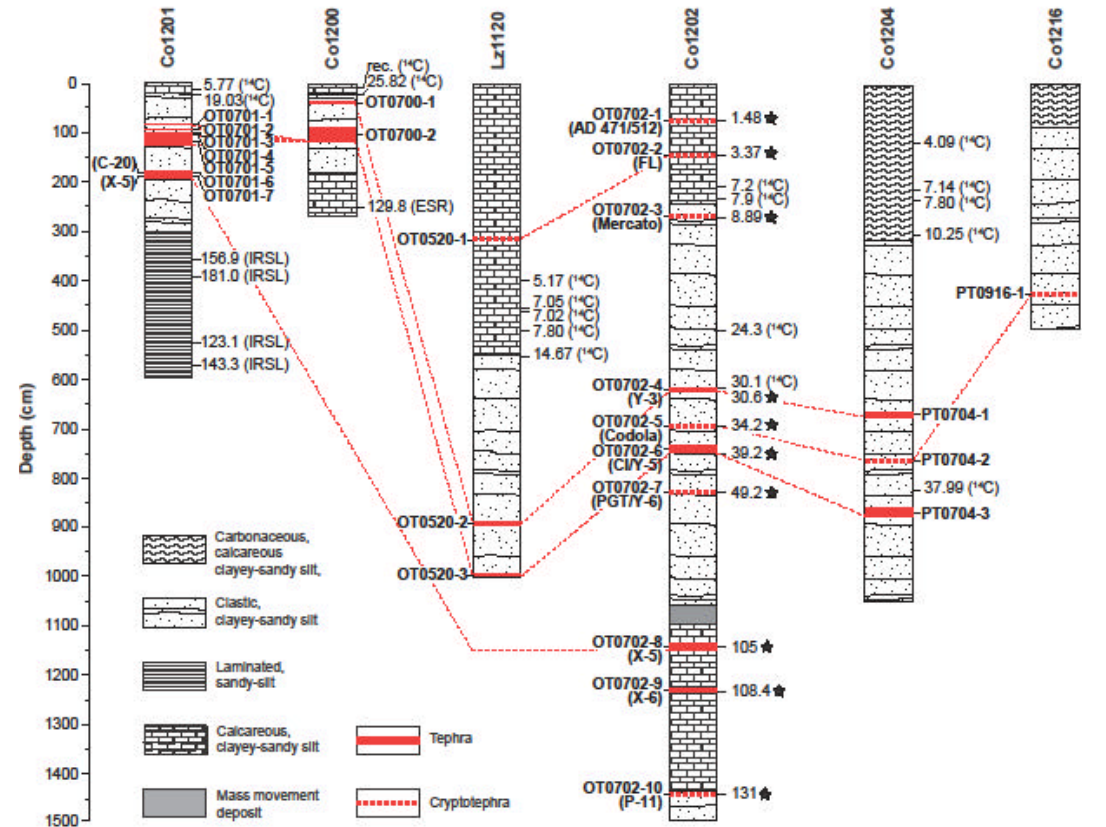
Fig. 2. Summary of stratigraphy and lithology of the studied cores. The thicknesses and sediment depths of tephras and cryptotephras are indicated by red horizons. Nomenclature of tephra layers for cores Co1200 (OT0700-x), Co1201 (OT0701-x), Co1202 (OT0702-x), Lz1120 (OT0520-x), Co1204 (PT0704-x), and Co1216 (PT0916-x) refers to the text. Nomenclature in brackets refers to the coding given to correlated tephra layers and or their parent eruptions. Dashed lines between the cores indicate the correlation of individual tephras and cryptotephras. Independent age control for the different sediment successions is given by radiocarbon (14C) dating for cores Co1200 (Lindhorst et al., 2010), Co1201 (Lindhorst et al., 2010), Co1202 (Vogel et al., 2010a), Lz1120 (Wagner et al., 2008), Co1204 (Wagner et al., 2010) as well as infrared stimulated luminescence (IRSL), and electron spin resonance (ESR) dating for cores Co1200 and Co1201 (Lindhorst et al., 2010). Stars indicate literature ages of tephra layers and/or their parent